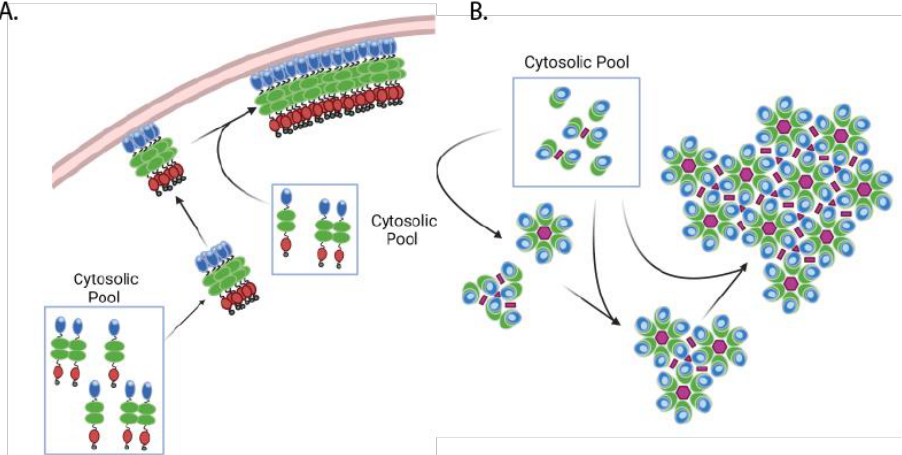
Figure 3. Immature lattice establishment and assembly progression. Side view ( A ) and top view ( B ) of lattice formation and growth. Initial Gag complexes arrive at the plasma membrane from the cytosol, potentially in complex with genomic RNA. Higher order multimerization occurs at the plasma membrane, with monomeric and dimeric Gag (from the cytosolic pool) added to the growing lattice edges. Gag domains are shown in the same color scheme as in Figures 1 and 2. Pink polygons depict different CA-CA interfaces as described in Figure